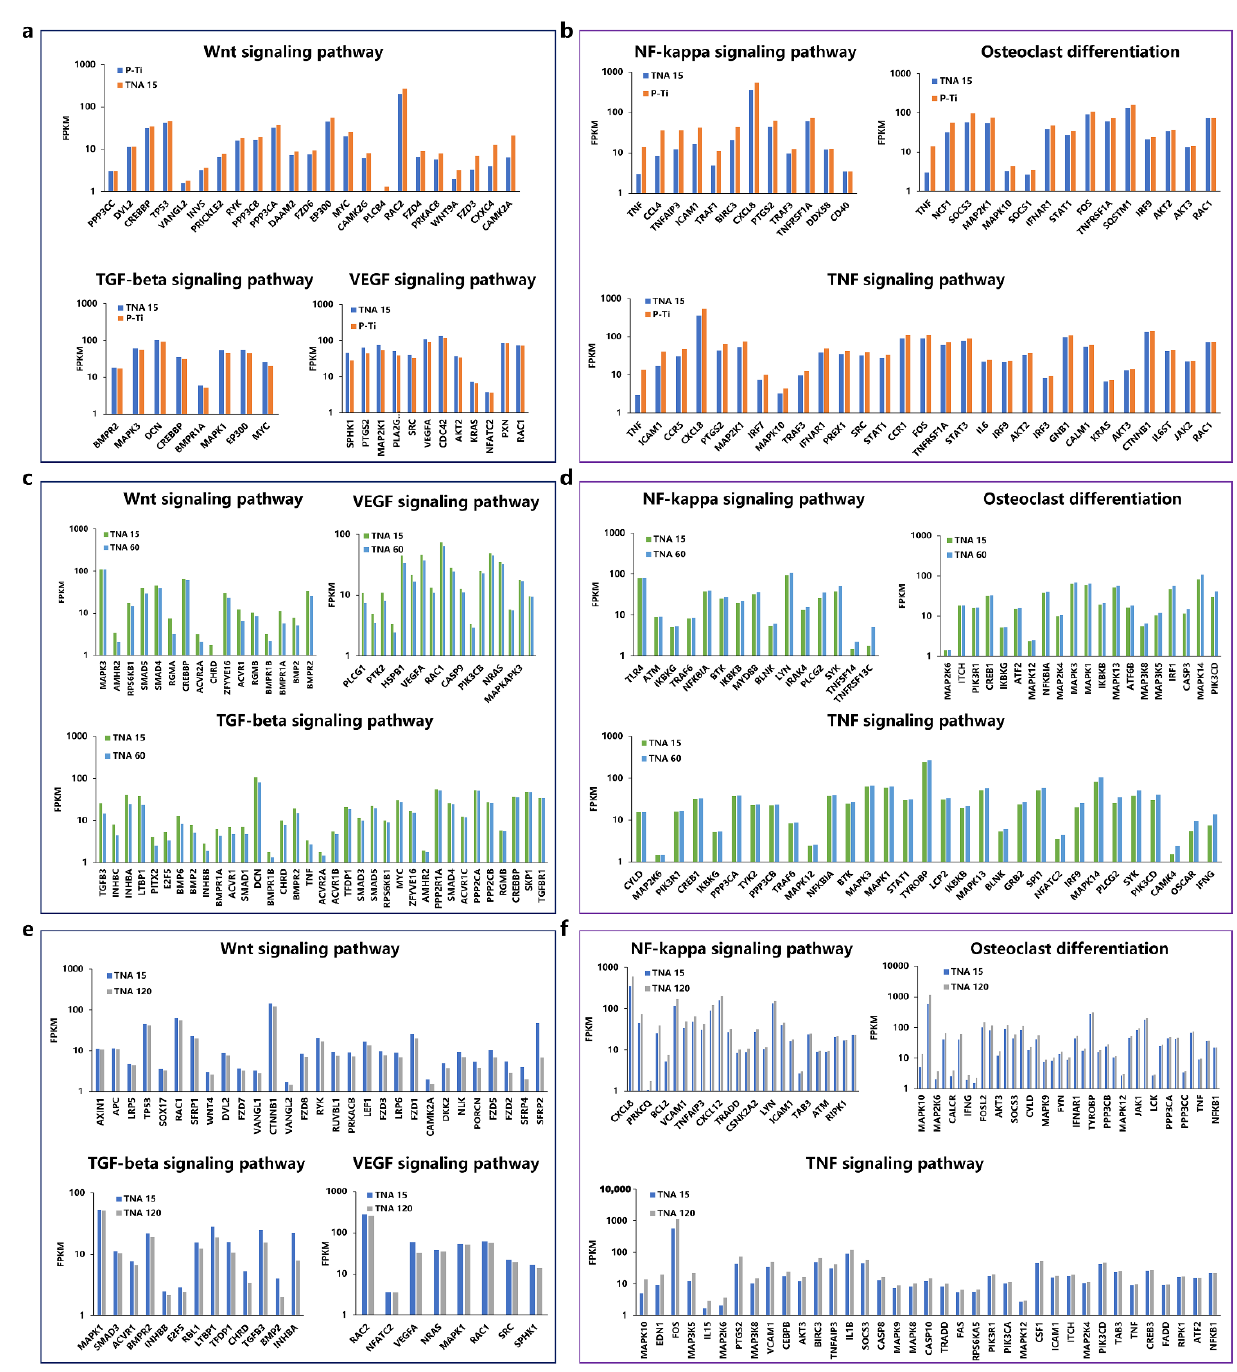
Figure 7. ( a ) Upregulated genes in the Wnt, TGF-beta, and VEGF signaling pathways within the comparison TNA 15 vs. P-Ti. ( b ) Downregulated genes in the osteoclast differentiation, TNF, NF-kappa signaling pathways within the comparison TNA 15 vs. P-Ti. ( c ) Upregulated genes in the WNT, TGF-beta, and VEGF signaling pathways within the comparison TNA 15 vs. TNA 60. ( d ) Downregulated genes in the osteoclast differentiation, TNF, NF-kappa signaling pathways within the comparison TNA 15 vs. TNA 60. ( e ) Upregulated genes in the Wnt, TGF-beta, and VEGF signaling pathways within the comparison TNA 15 vs. TNA 120. ( f ) Downregulated genes in the osteoclast differentiation, TNF, and NF-kappa signaling pathways within the comparison TNA 15 vs. TNA